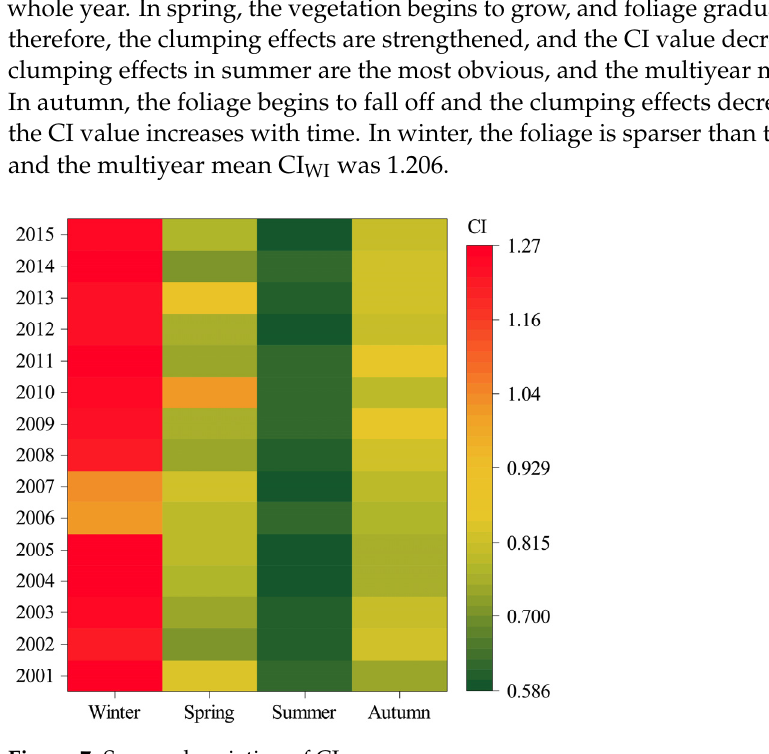
Figure 7. Seasonal variation of CI.